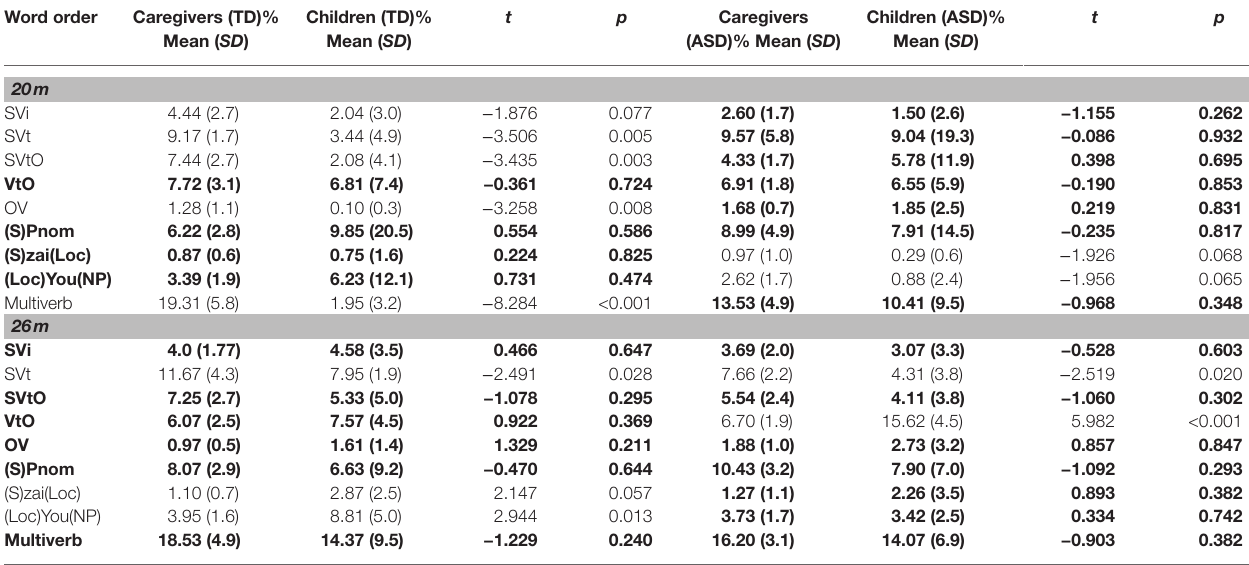
TABLE 4 | Children’s word orders uses compared to caregivers by diagnostic groups. Word